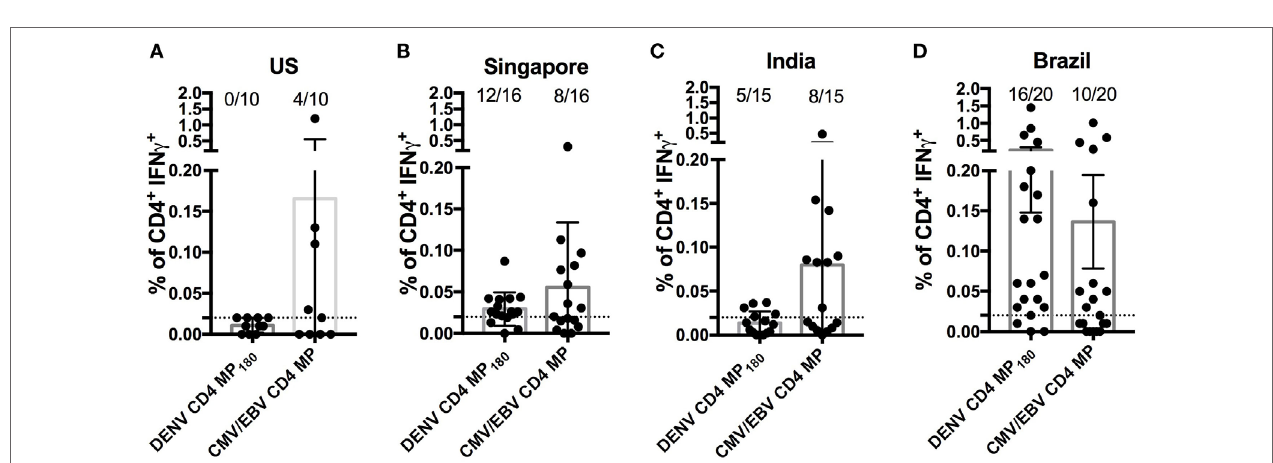
FigUre 6 | Assessment of dengue virus (DENV) CD4 MP 180 reactivity in diverse geographical locations. Percentage of CD4 + T cells producing IFN γ upon stimulation with DENV CD4 MP 180 in flavivirus naïve ( n = 10) (a) and DENV exposed Singaporean ( n = 16) (B) , Indian ( n = 9) (c) , and Brazilian ( n = 20) (D) donor cohorts. CMV/ EBV CD4 MP stimulation was used as a control. To allow for comparison of the responses frequencies against the CMV/EBV and the dengue-specific response in all new cohorts the data showing response frequencies against the DENV CD4 MP 180 in the Brazilian cohort from Figure 5D has been re-plotted in Figure 6D . Data are expressed as mean ± SEM, and the dashed lines at 0.02% represent the cutoff of positivity.